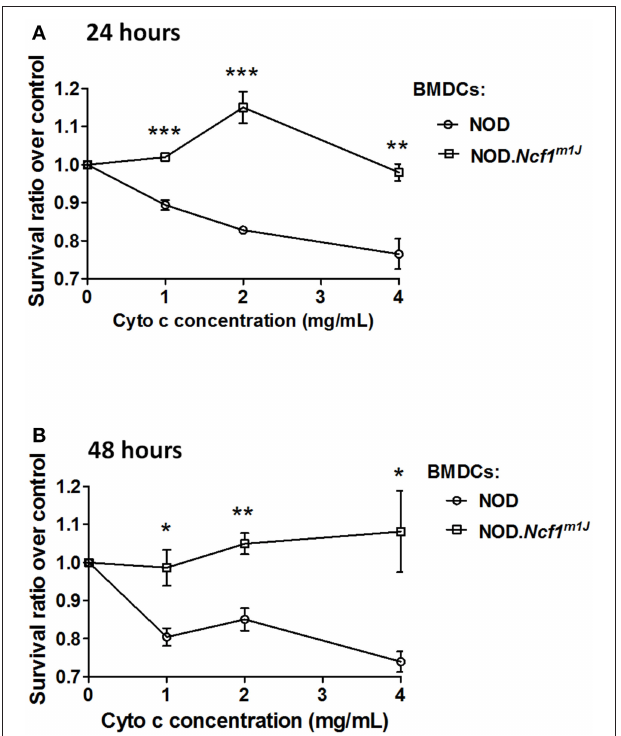
FIGURE 6 | Deficient antigen translocation into cytoplasm in NOD- Ncf1 m1J DCs. DCs were treated with cytochrome c with various concentrations for 24h (A) or 48h (B) . Cell survival rate was represented as the ratio between treated and non-treated groups. Data are represented as mean ± SEM. Statistical analysis used Student’s t -test. * p < 0.05; ** p < 0.01; *** p < 0.001. to DC-G9C8 co-cultures. As expected, NOD- Ncf1 m1J DCs were